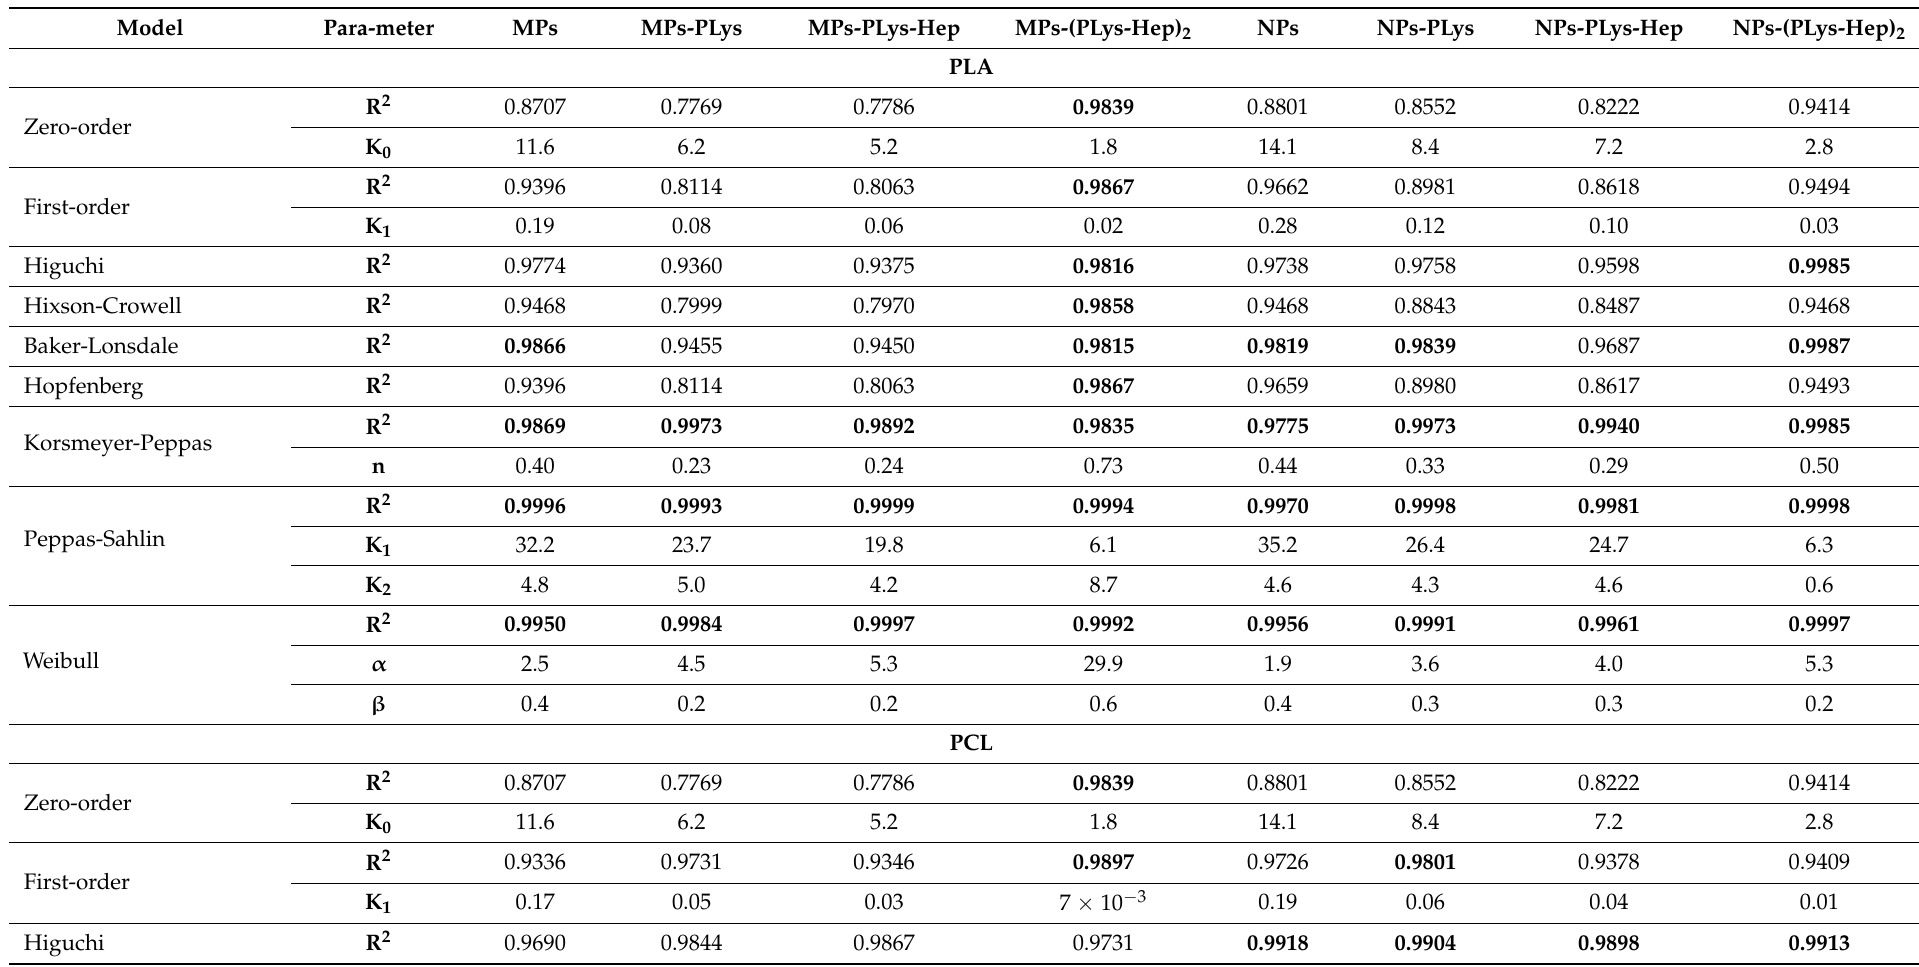
Table 2. Correlation coefficients and constants evaluated by fitting prednisolone release profiles during first six hours of release. The models used for drug release fitting, full curves fitting data and linearization curves are presented in Supplementary Materials (Tables S1–S4). PLA = poly(L-lactic acid), PCL = poly( ε -caprolactone), MPs = microparticles, NPs = and